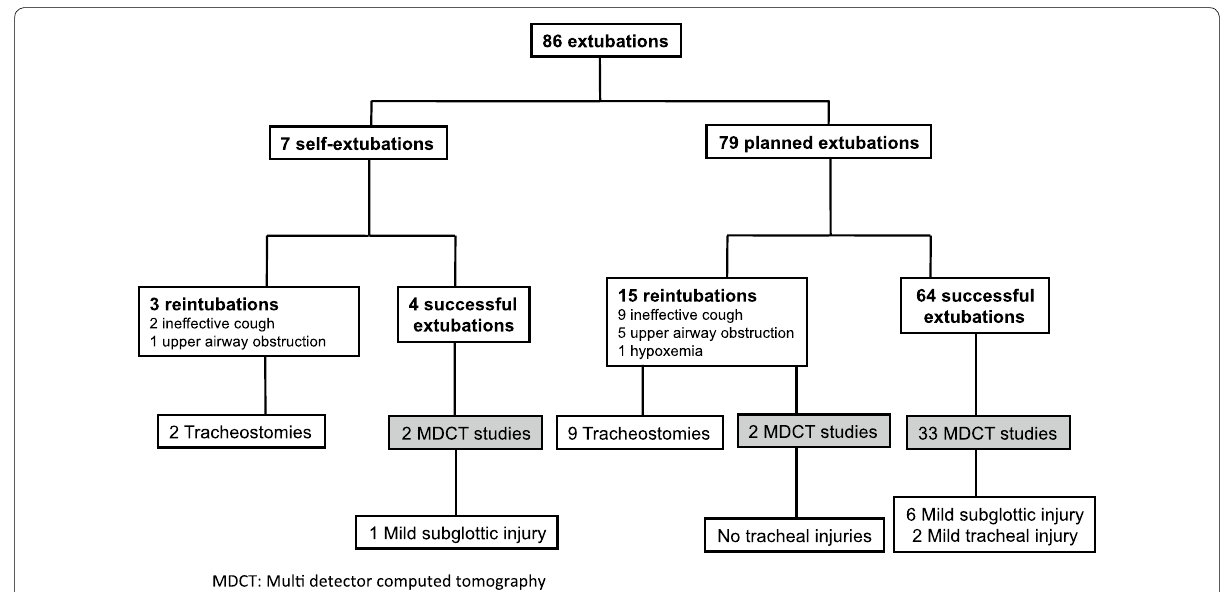
Fig. 2 Post‑extubation complications and results of MDCT